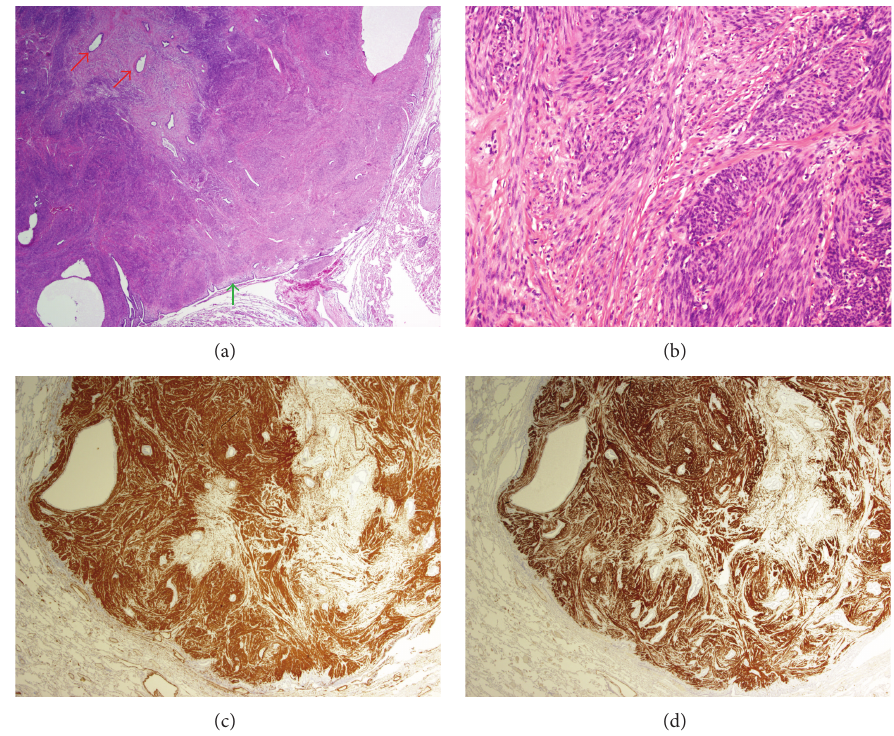
Figure 3: (a) A well-circumscribed tumor with a pushing border to the lung parenchyma (green arrow) (H&E, 40x). Note entrapped bronchiolar epithelium encircled by collagen (red arrows). (b) Bland smooth muscle cells without cytological atypia (H&E, 100x). (c) Diffuse staining (brown) for SMA (12.5x). Note negative staining (white) of collagen and bronchiolar epithelium in the tumor. (d) Diffuse staining (brown) for desmin (12.5x). There was negative tumor cell staining for p16, p53, WT-1, CD10, CD31, HMB-45, CD117/c-kit, and ALK-1 (not